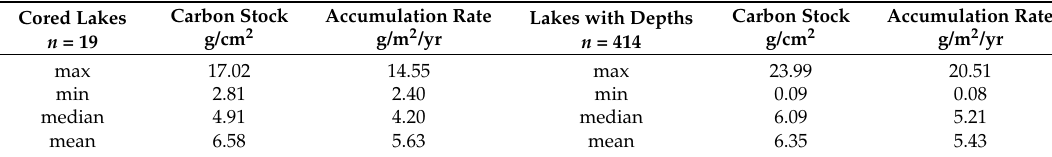
Table 4. Average Carbon Stocks and Accumulation Rates in Uinta Lakes.